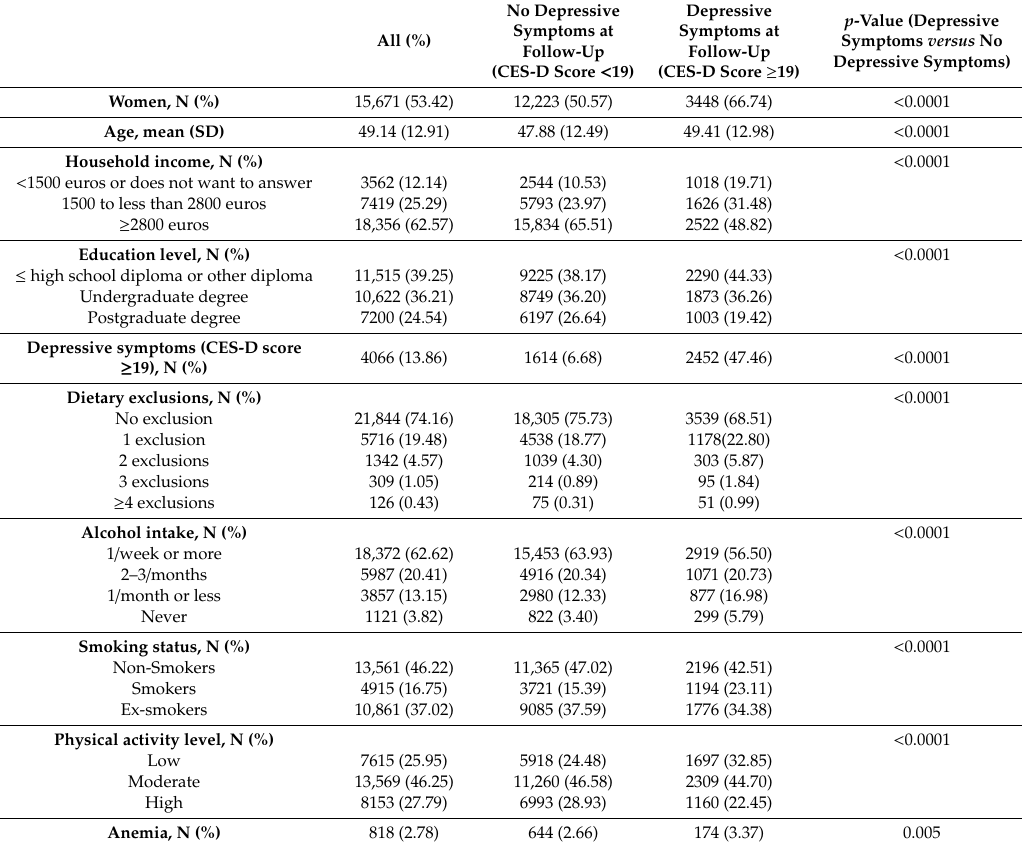
Table 1. Participant’s baseline characteristics by depressive symptoms at follow-up (N = 29,337).